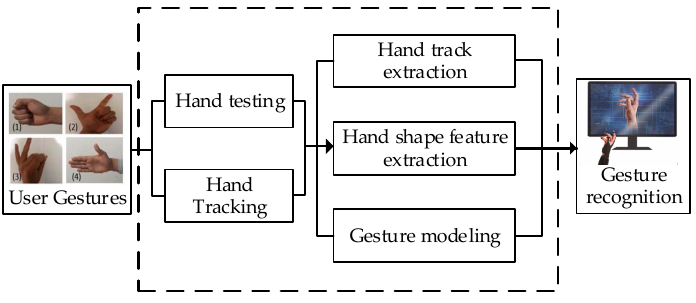
Figure 13. Generic gesture recognition flow chart.